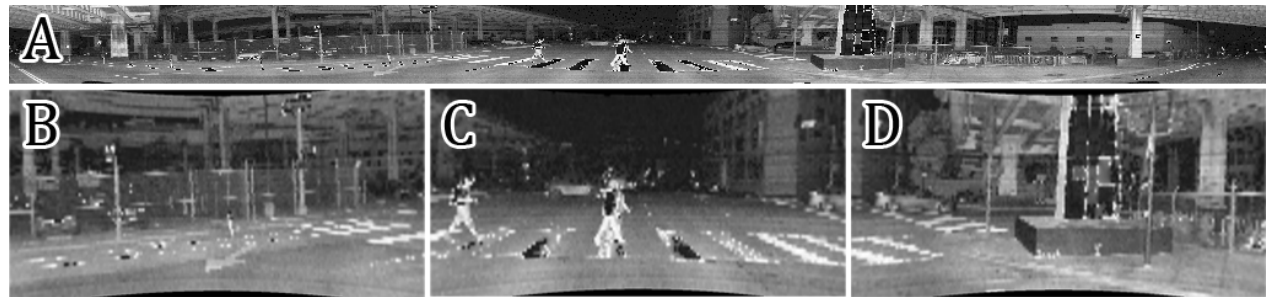
Figure 2. Comparison of a directly generated laser intensity image from Ouster OS1-64 ( A ), and the camera-like images ( B – D ) for the same scan from one of the publicly available OS1-64 sequences synthesized with our